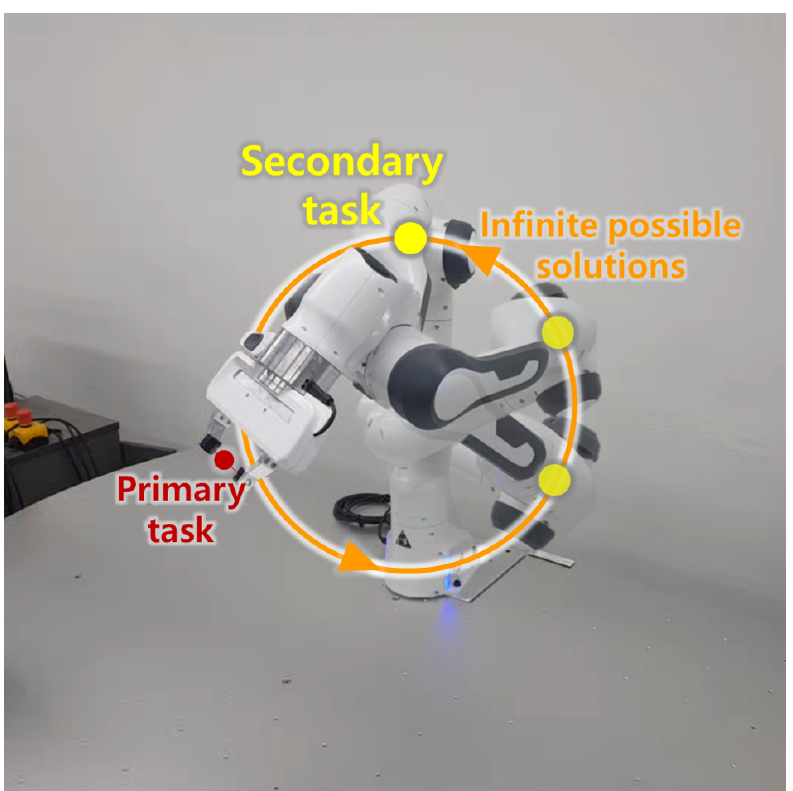
Figure 1. Actual model of the 7-DoF manipulator. The infinitely possible solutions of the 1-DoF secondary task are shown when performing the positioning and orienting at the end-effector as the primary